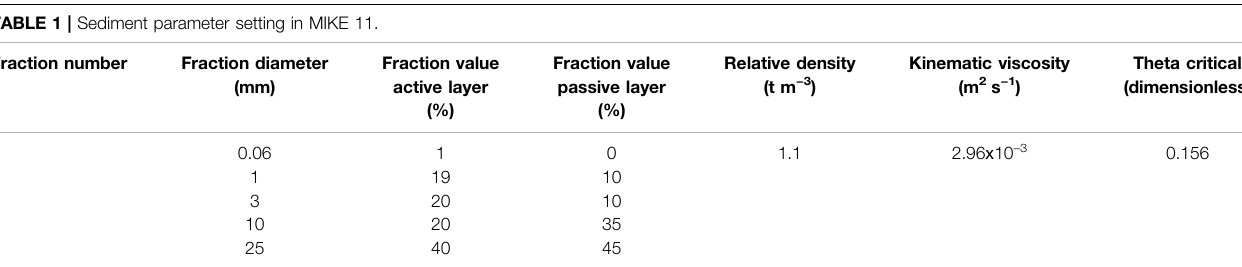
TABLE 1 | Sediment parameter setting in MIKE